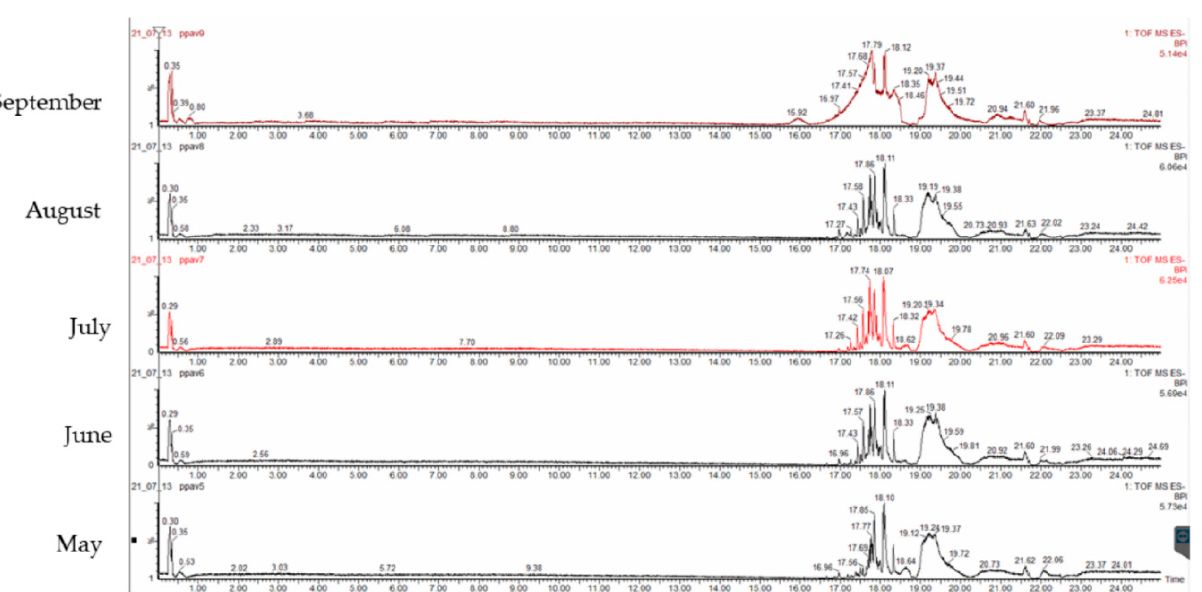
Figure 3. Chromatograms of the UPLC-PDA-ESI-QTOF analyses of P. pavonica .